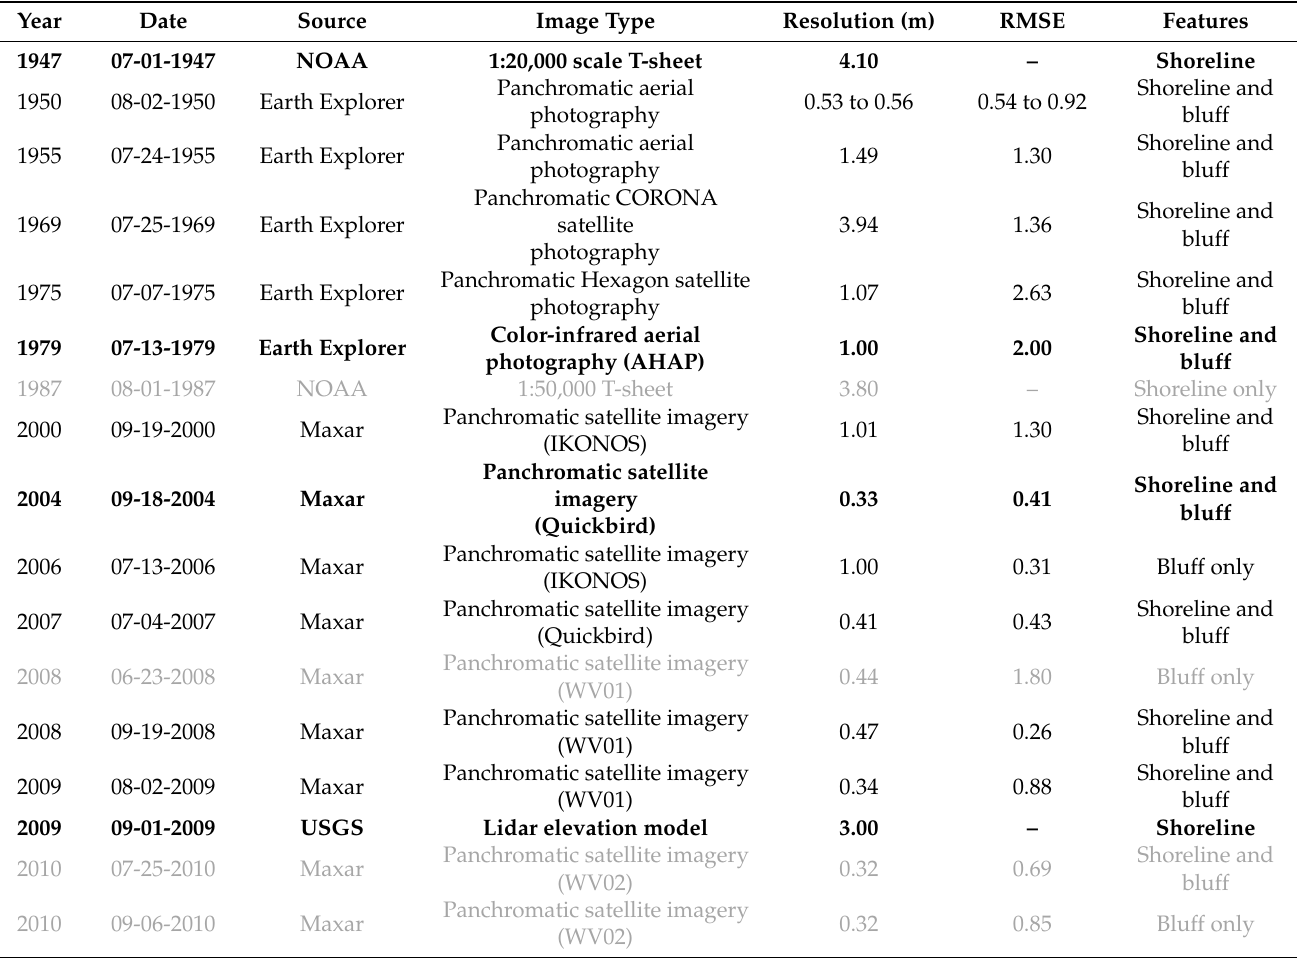
Table 1. Datasets used for bluff and shoreline change